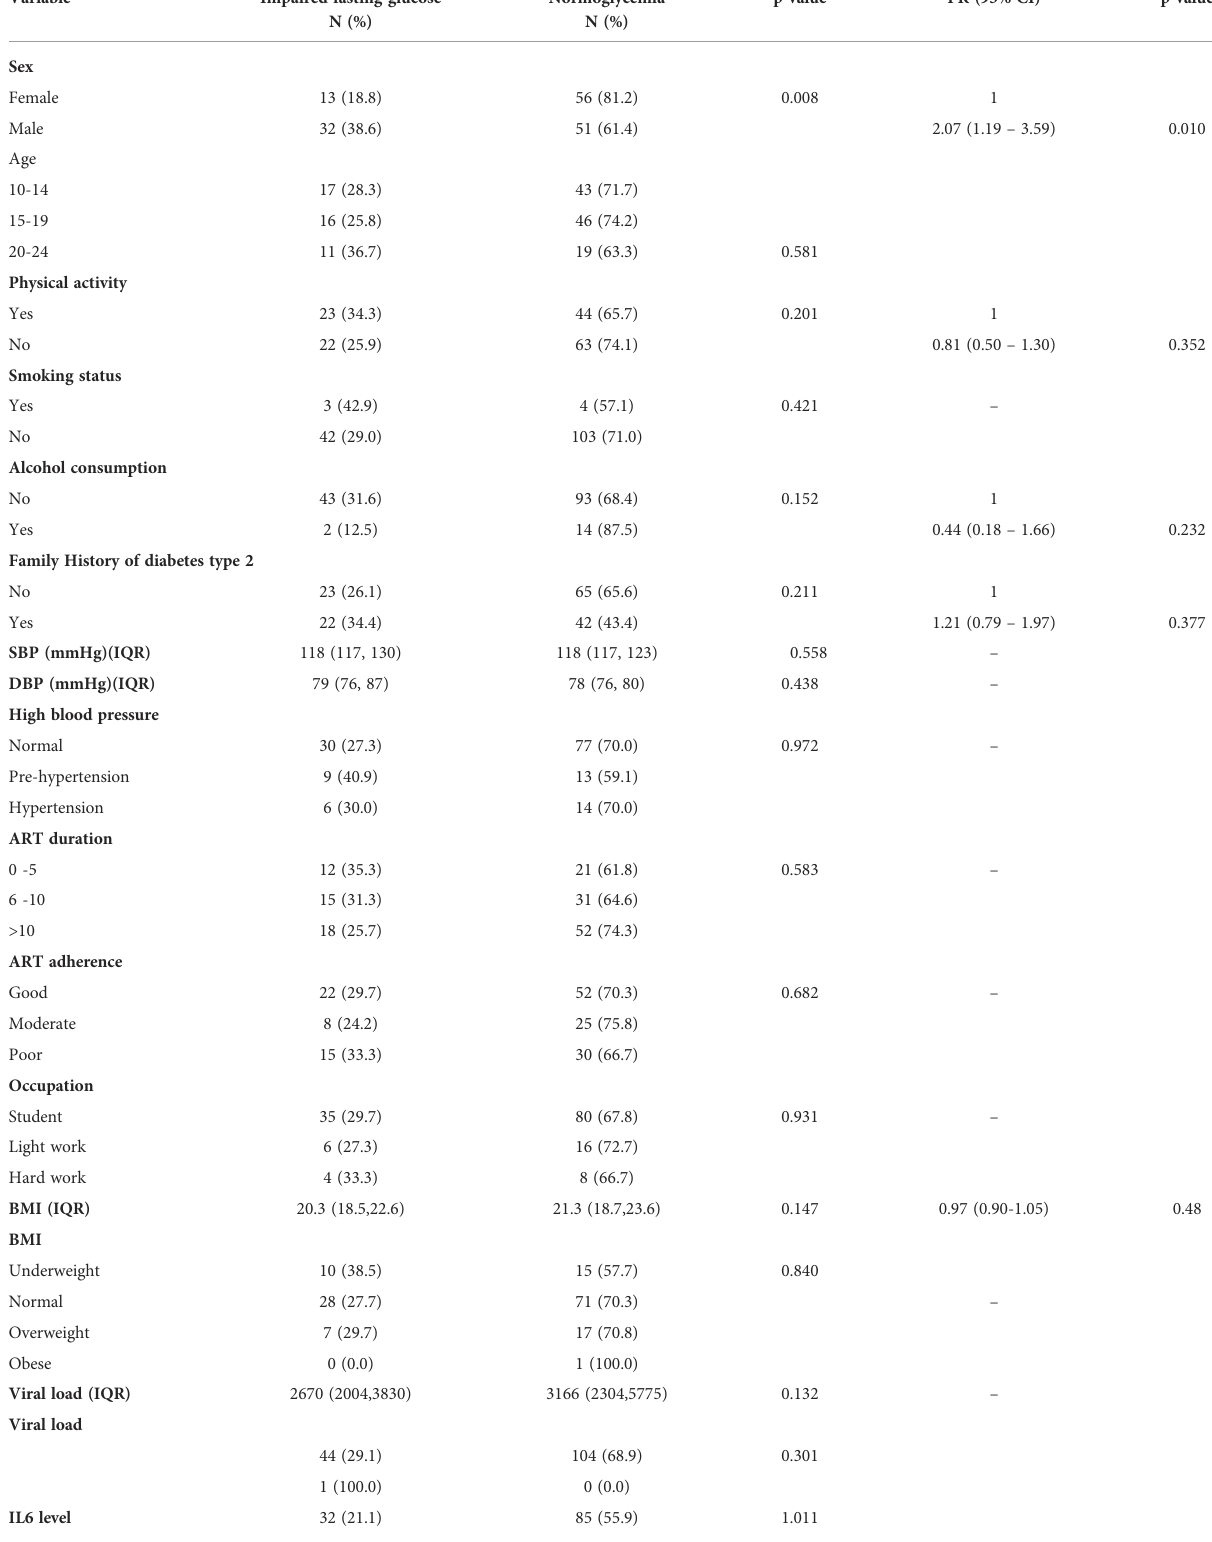
TABLE 3 Bivariate and Multivariate analysis of factors associated with impaired fasting